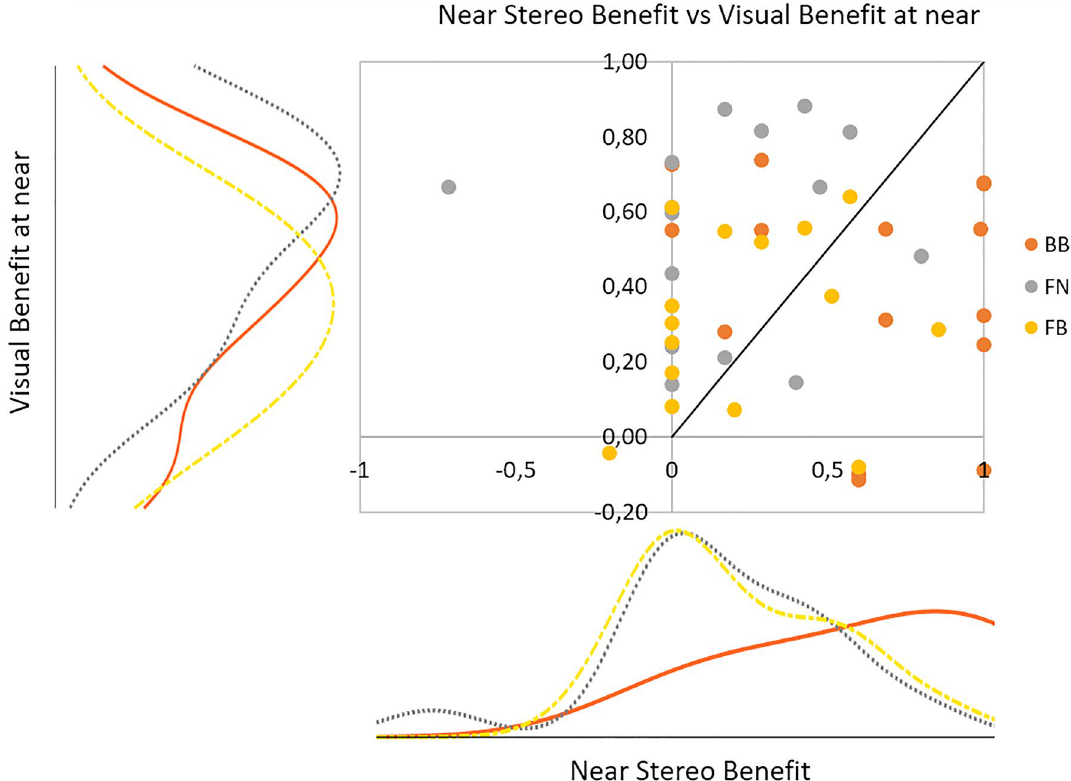
Figure 9. Near stereo benefit as a function of Visual Benefit at near for each presbyopic correction. The histograms show the distribution for each